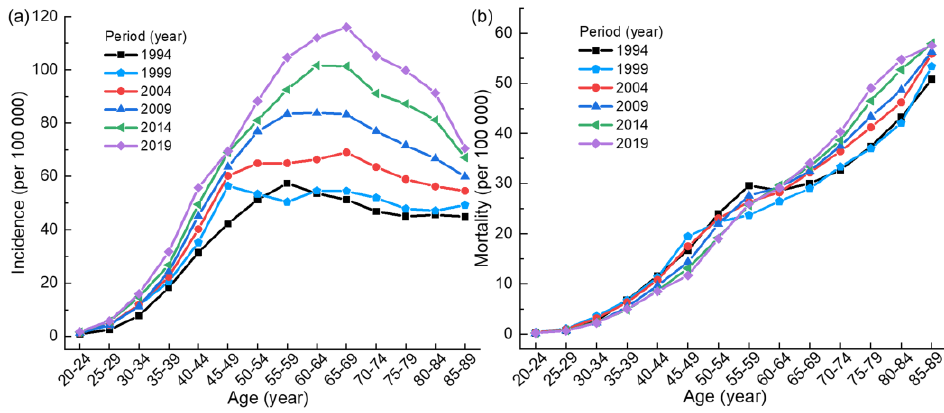
Figure 1. ( a ) Age trends of the incidence of breast cancer in Chinese women. ( b ) Age trends of the mortality of breast cancer in Chinese women.